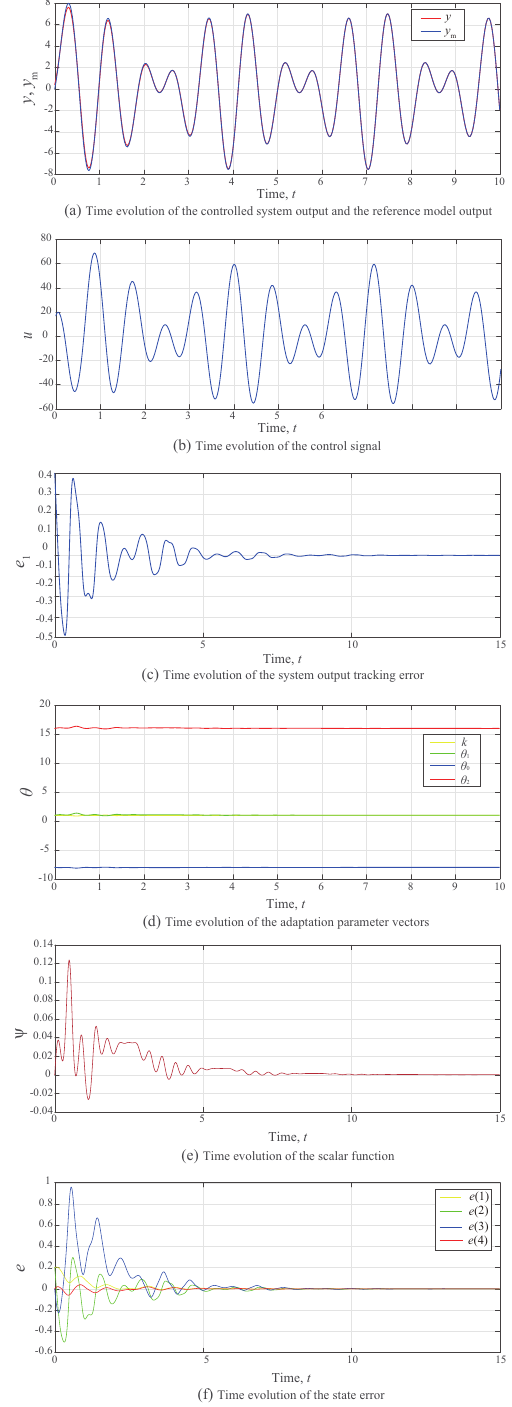
Figure 2. System response with the proposed